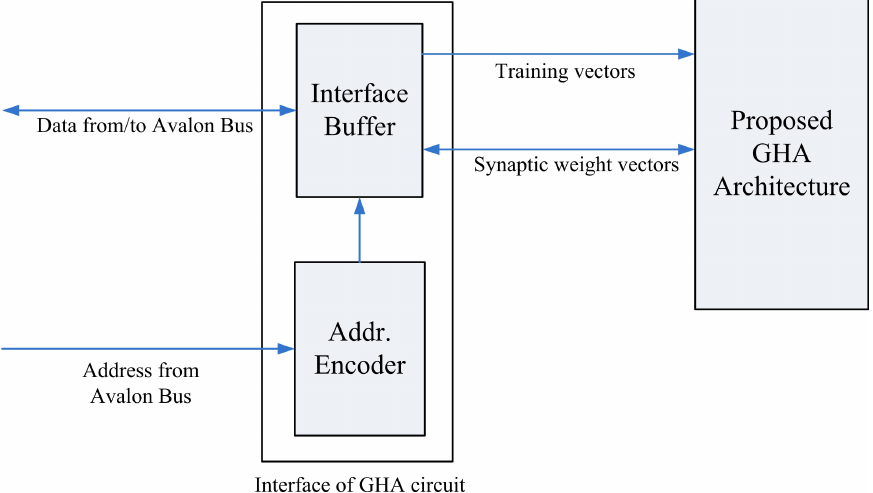
Figure 16. The interface of the proposed architecture to the SOPC